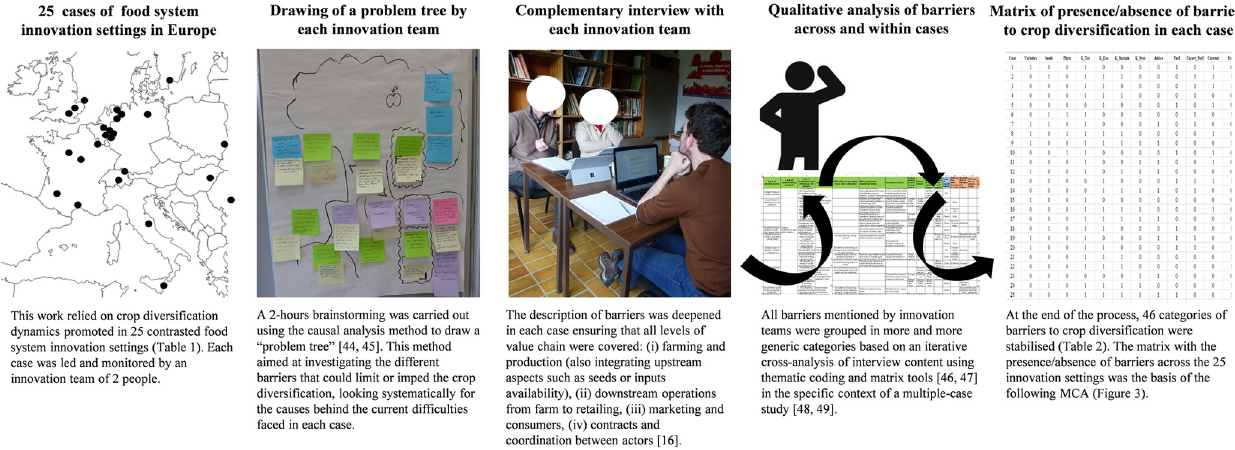
Fig 2. Presentation of the different methodological steps involved in the characterisation of barriers to crop diversification across the 25 European food system innovation settings. The individual appearing here has given written informed consent (as outlined in PLOS consent form) to publish these case details.